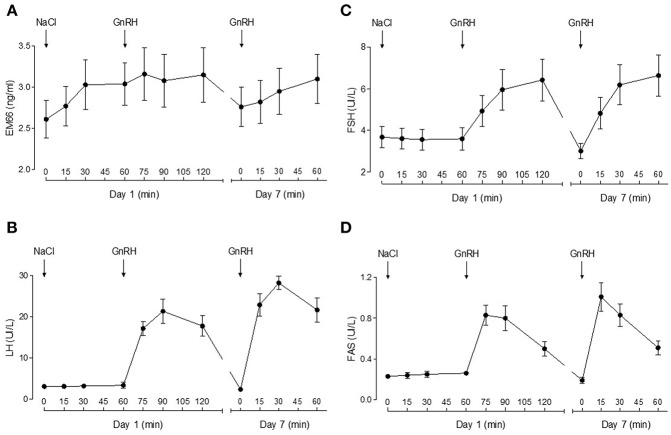
Plasma EM66 and gonadotropin levels of healthy men during stimulatory or inhibitory conditions of the reproductive axis. Results of dynamic tests for evaluation of EM66 (A), LH (B), FSH (C), and FAS (D) levels in plasma of healthy men. Day 1: response of EM66 and gonadotropins after intravenous administration of vehicle followed by 100 μg GnRH. Day 7: response of EM66 and gonadotropins after 7 days administration of percutaneous DHT (125 mg twice daily) followed by 100 μg GnRH. Values are means ± SEM (n = 8).